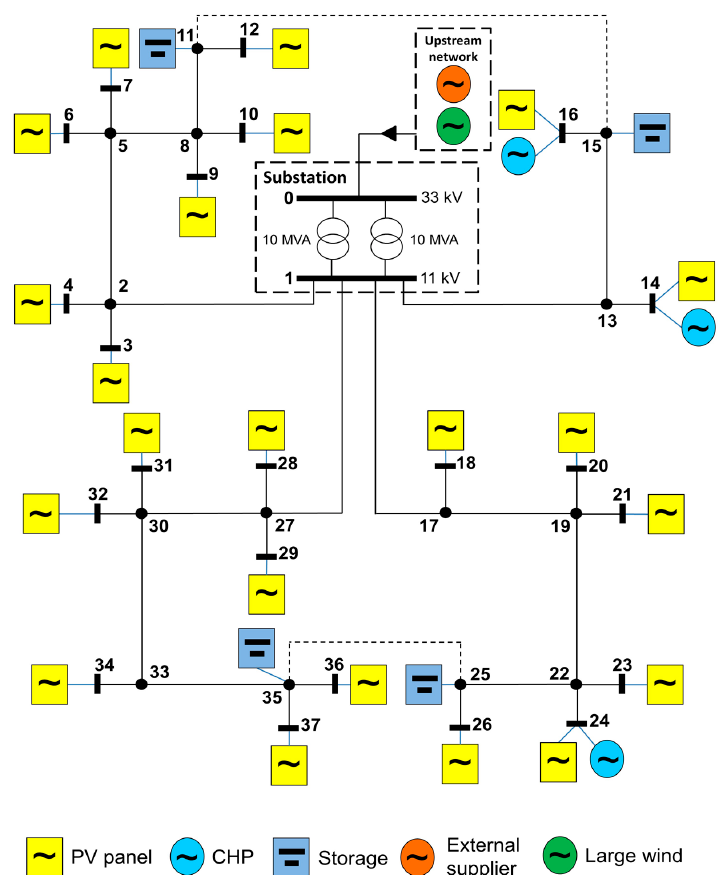
Figure 4. 37-Bus distribution network with distributed energy resources (DERs) penetration for 2050.